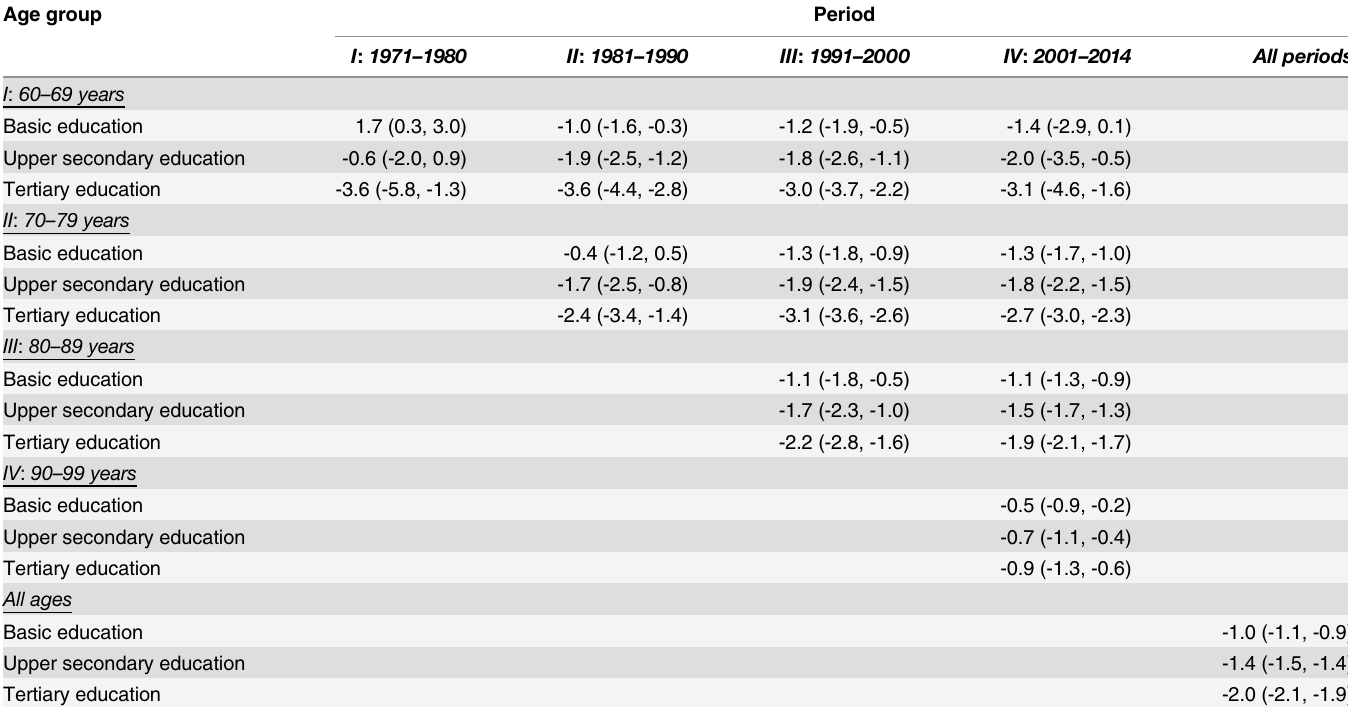
Table 3. Average annual change in one year death risk, in per cent (95% CI) from clog-log models by age group and period, women. Age